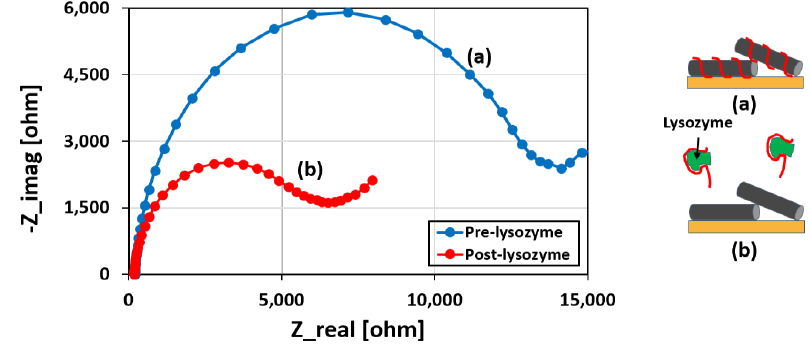
Figure 5. Effect of lysozyme exposure on the printed sensor. Nyquist curves for ( a ) pre- and ( b ) post-lysozyme conditions. It can be observed that lysozyme (1 µg/mL) exposure reduces the charge transfer resistance (R ct ) because of the unwrapping of the anti-lysozyme aptamers from the CNTs to capture the lysozyme protein.